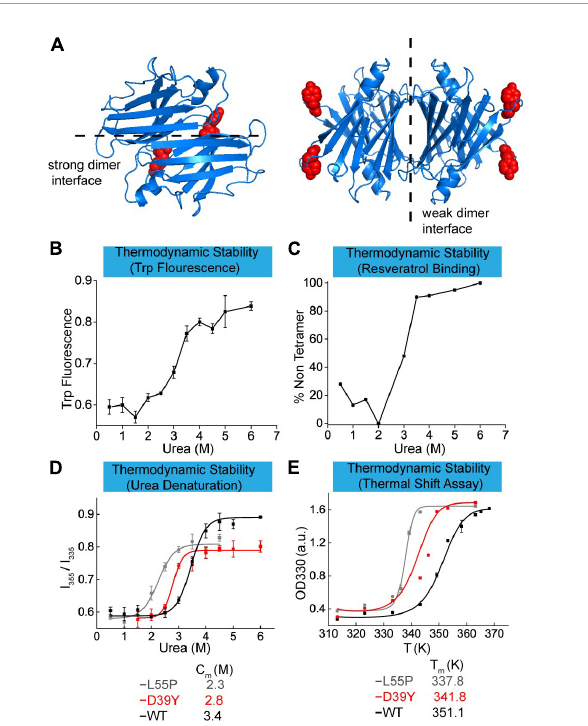
FIGURE2 Thermodynamic stability of TTR-D39Y. (A) X-ray crystallographic structure of D39Y-TTR modified from WT-TTR (PDB code: 1BMZ). Y-39 was highlighted in red. (B) Urea-mediated unfolding of TTR-D39Y measured by tryptophan fluorescence changes (ratio at 355 nm and 335 nm). (C) Urea-mediated tetramer dissociation of TTR-D39Y measured by resveratrol binding fluorescence (394 nm). (D) Denaturation curve measured by tryptophan